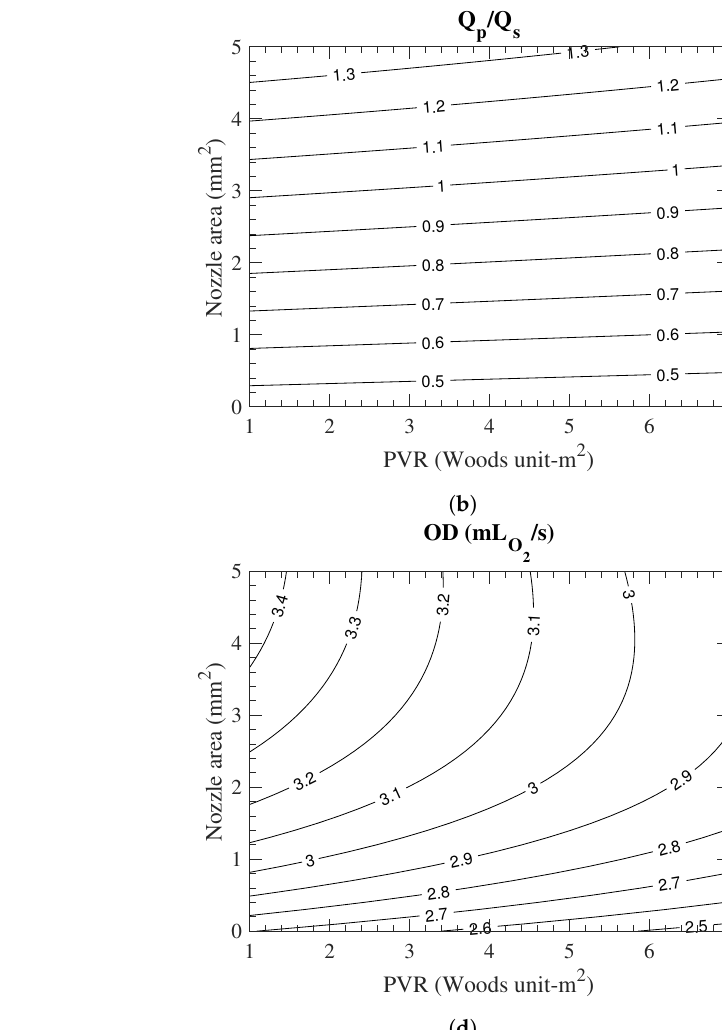
Figure 14. ( a ) The cardiac output, ( b ) the pulmonary-to-systemic flow ratio, ( c ) the aortic oxygen saturation, and ( d ) the oxygen delivery as functions of the nozzle area and the PVR. These results are produced by the algebraic